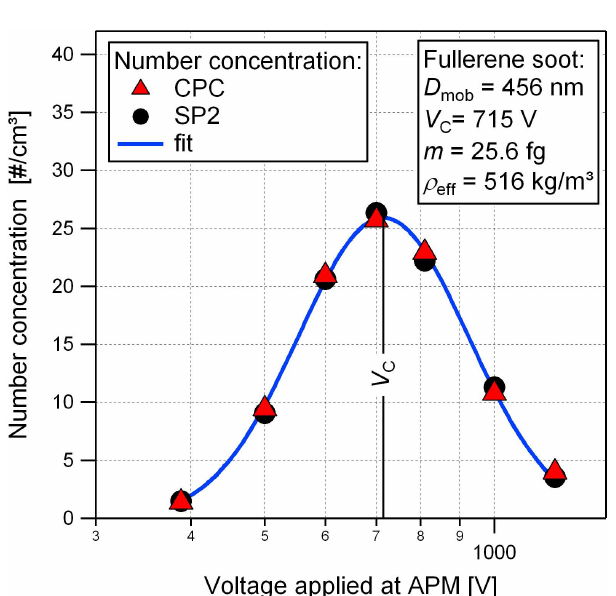
Fig. 2. Classification of fullerene soot particles with mobility di- ameter D mob =456nm with the DMA-APM system. Raw number concentration is shown as a function of voltage applied at the APM. The mass, m =25.6fg, of the monodisperse particles, is obtained from the voltage, V c , where the fitted number concentration is at a maximum (APM operated at 2000